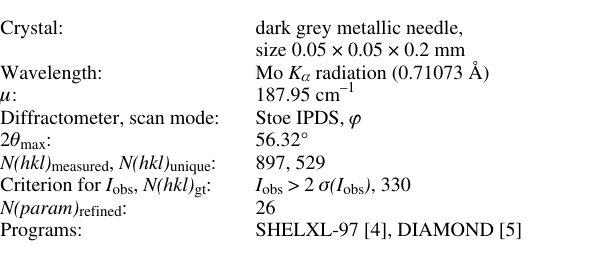
Table 1. Data collection and